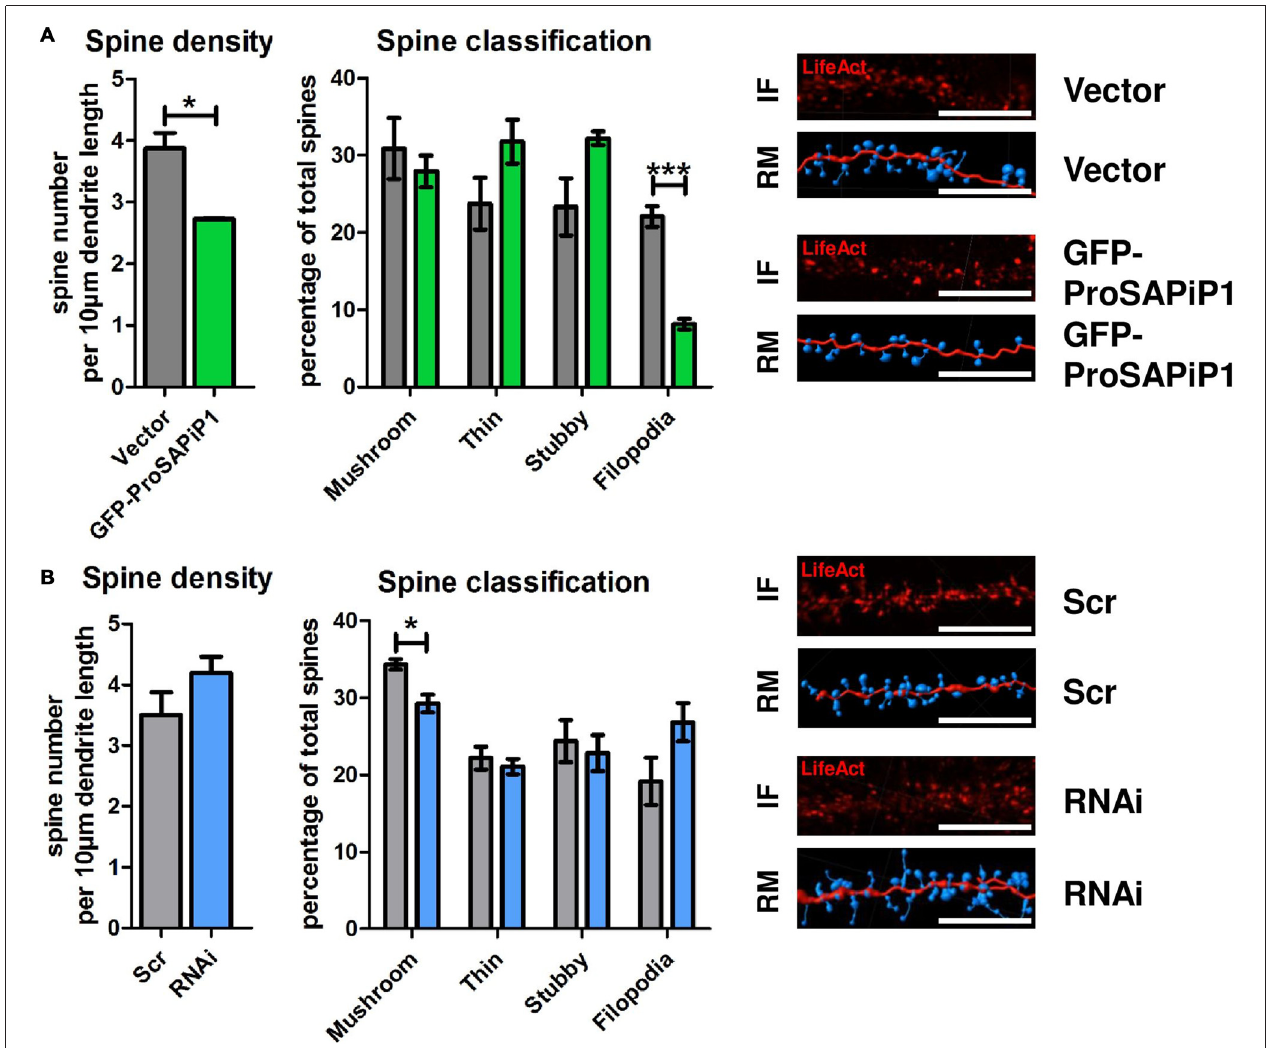
FIGURE 4 | Analysis of dendritic spines after ProSAPiP1 overexpression and knockdown in mature primary hippocampal neurons. (A,B) For spine analysis, neurons infected with Vector, GFP-ProSAPiP1, Scr or RNAi were additionally infected with RFP-tagged LifeAct visualizing F-actin on DIV24 and processed for analysis on DIV28. (A) Spine density and the percentage of filopodia were significantly decreased in neurons overexpressing GFP-ProSAPiP1 as indicated. (B) Spine density remained unchanged between Scr and RNAi while the percentage of mushroom-like spines was significantly decreased after knockdown of ProSAPiP1 as indicated. (A,B) IF, immunofluorescence; RM, reconstructed model. Scale bar: 10 µ m. Statistical analysis was performed using unpaired two-sided t -test. ∗ p < 0.05; ∗∗∗ p < 0.001. n = 15 neurons from three independent